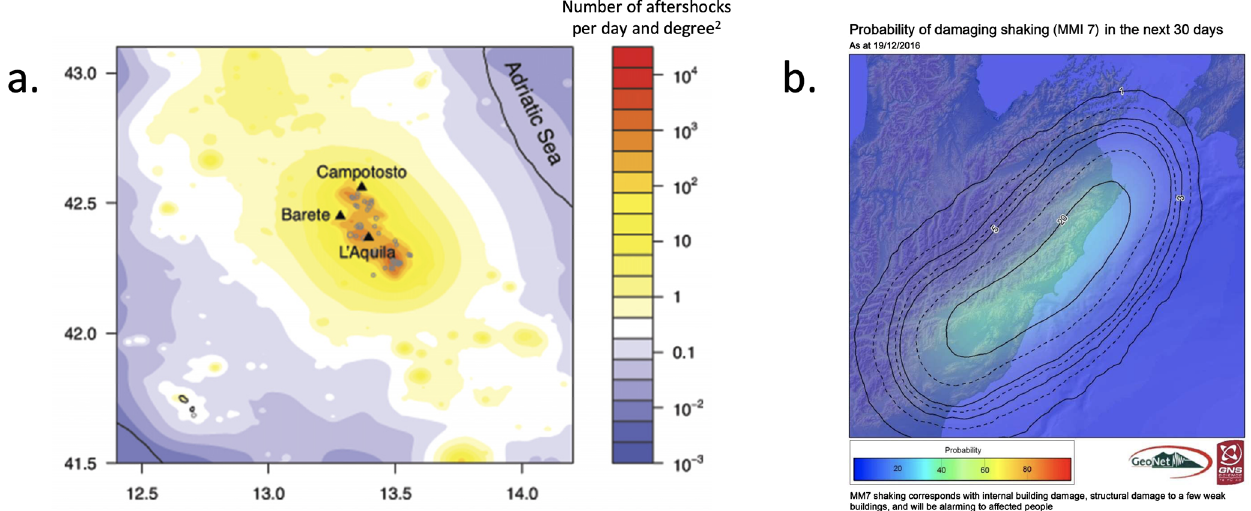
Figure 1. Two examples of aftershock forecasts. (a) A map showing the expected daily number of aftershocks above magnitude 2.0 several weeks after the L’Aquila, Italy, earthquake of 2006 (reprinted from Murru et al., 2015). (b) A map showing the forecasted probability of a damaging aftershock (defined as having a Modified Mercalli Intensity – MMI – score above 7) in the month following the Kaik¯oura, New Zealand, earthquake of 2016, released to the public by New Zealand’s GNS Science (reprinted from Becker et al., 2020). As damaging earth- quakes are rare, even probabilities above 10% may constitute a significant risk, though disentangling the uncertainty around this forecasted probability is not possible from this